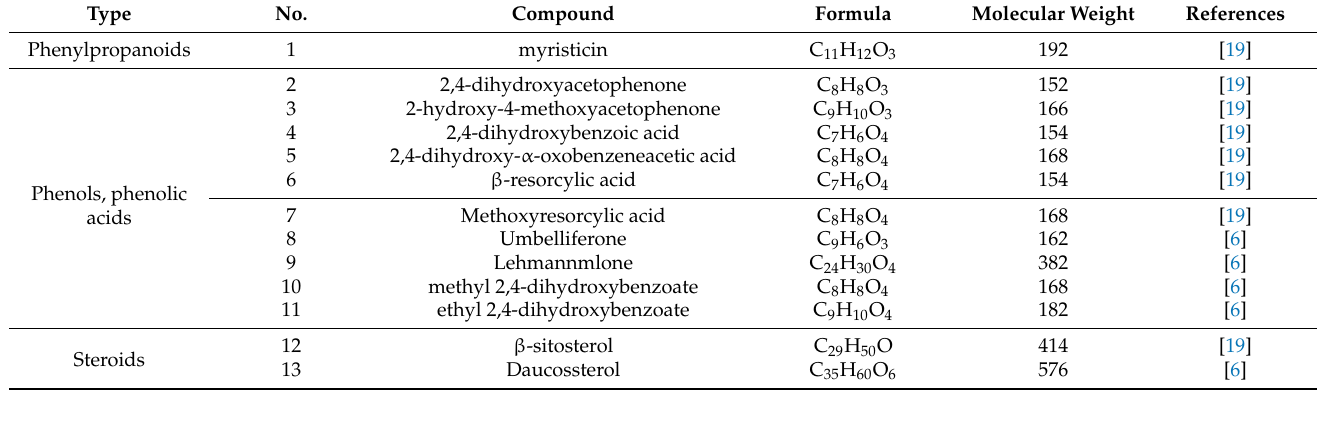
Table 3. Other chemical constituents of F. ferulaeoides.